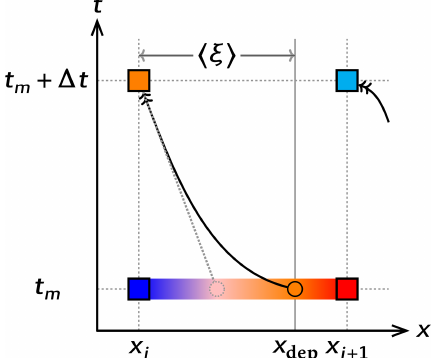
Figure 1. Schematic illustration of advection and semi-Lagrangian scheme. The new state computation for a target point x j from time t m in the case of u j < 0 is presented. The colors symbolically ex- press the value of field variables. The boxes correspond to model grid points. The solid arrow is the trajectory of one particle and the solid circle is the departure point. In a semi-Lagrangian scheme, the distance to the departure point, (cid:104) ξ (cid:105) , is computed using an assumed trajectory. Interpolating the state at departure point x dep , the value is advected to the arrival point (x j ,t m + (cid:49)t) . The dotted arrow and circle correspond to the trajectory and departure point in a differ- ent case while assuming a constant velocity, which may lead to a different